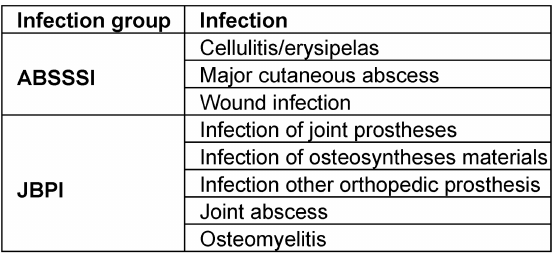
Table 1: Overview of infection entities for